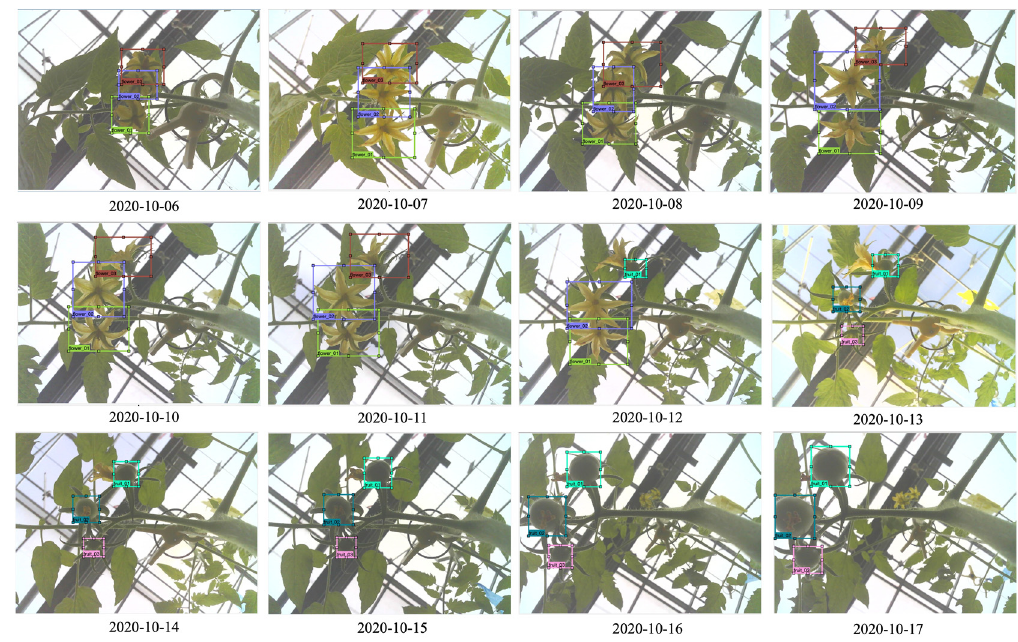
Figure 10. Bloomed flowers and immature fruits tracking in tomato.